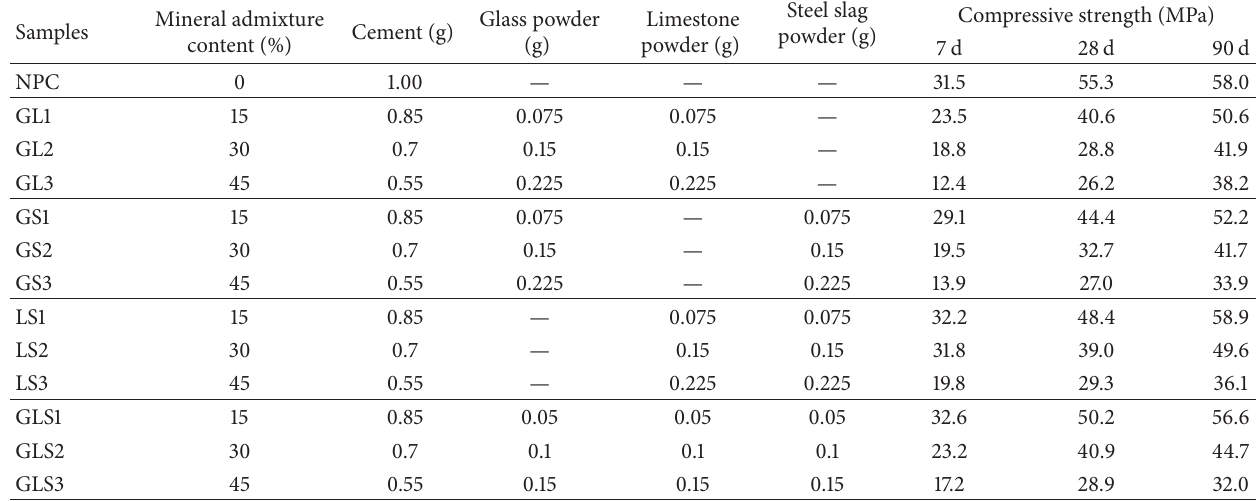
Table 5: Mix proportion of pastes and compressive strength of paste/MPa.